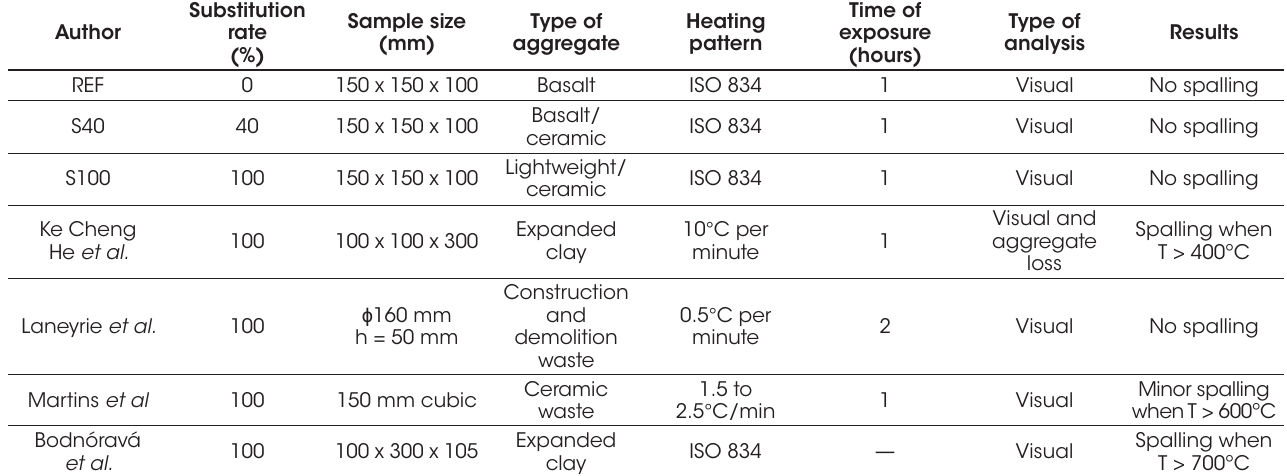
Table 5 Comparative data of the test parameters (spalling)